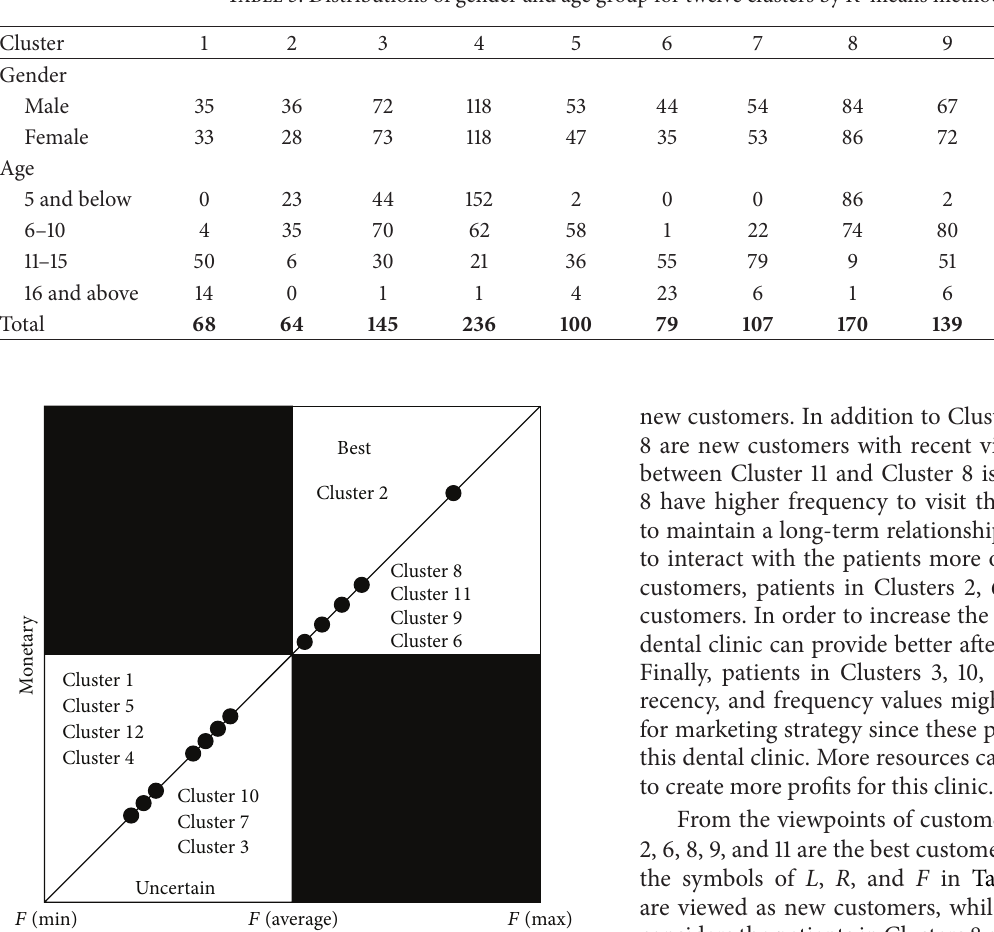
Table 5: Distributions of gender and age group for twelve clusters by K -means method.